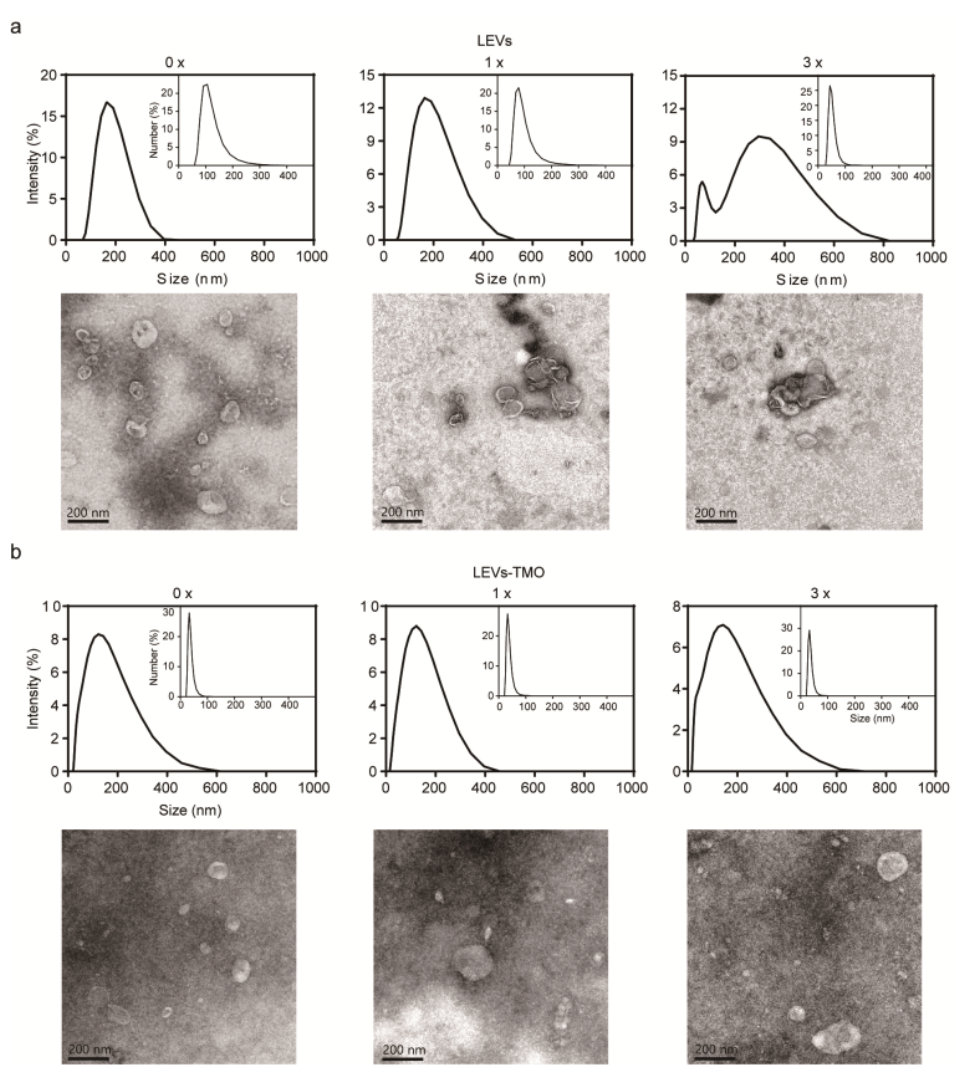
Figure 4. Size distributions of LEVs and LEVs-TMO over freeze-thaw cycles. ( a ) Top: Dynamic light scattering (DLS) measurements of the size distribution intensity for LEVs exposed to 0, 1, and 3 freeze-thaw cycles. Insets: number-size distribution curves. Bottom: TEM images of LEVs exposed to different numbers of freeze-thaw cycles. ( b ) Top: DLS measurements of the size distribution intensity for LEVs-TMO exposed to 0, 1, and 3 freeze-thaw cycles. Insets: number size distribution curves. Bottom: TEM images of LEVs-TMO of different freezing and thawing cycles. Data are presented as mean ± standard error of mean (SEM).